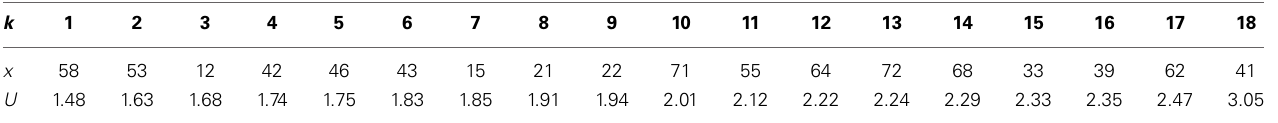
Table 1 | Uncertainty U k of individual listener with index k .